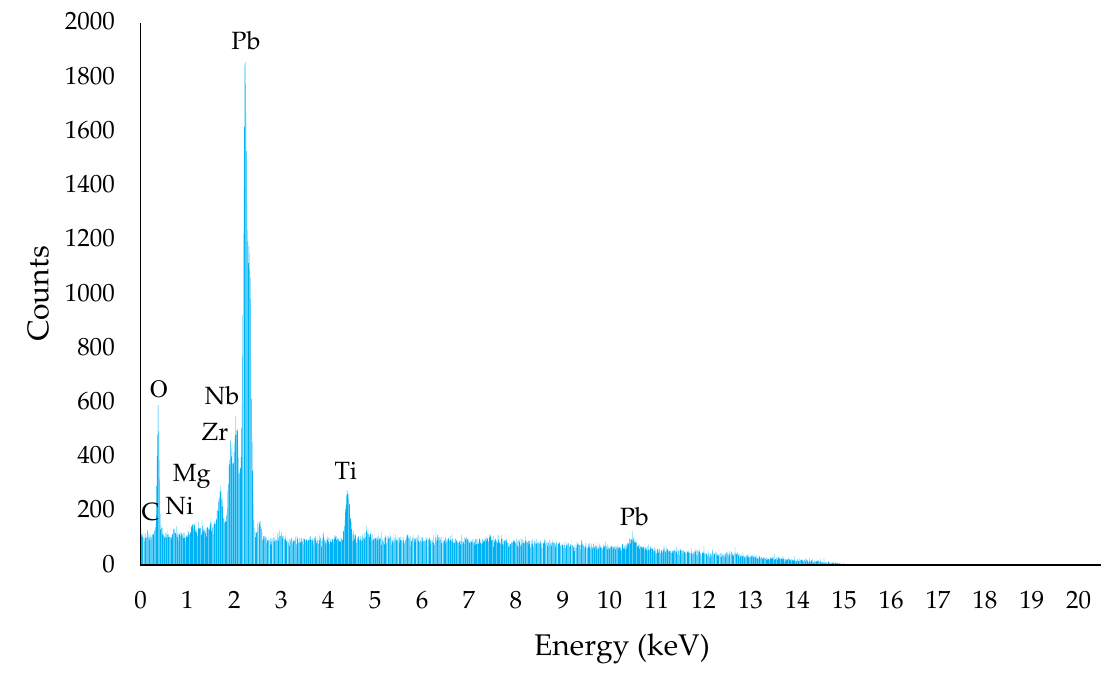
Figure 10. EDXS spectrum of unsintered PZT film.